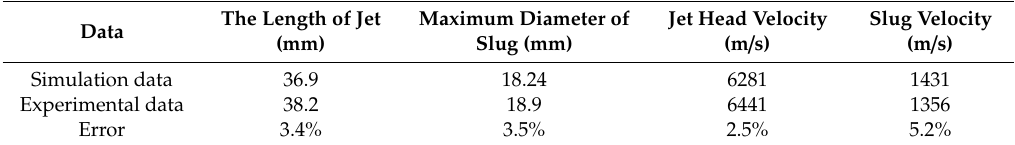
Figure 17. The numerical simulation of Mo-10Ta jet forming, ( a ) velocity gradient nephogram (cm / µ m), ( b ) equivalent plastic strain nephogram, ( c ) temperature nephogram (K). Table 3. Verification of Mo-10Ta J–C constitutive model.